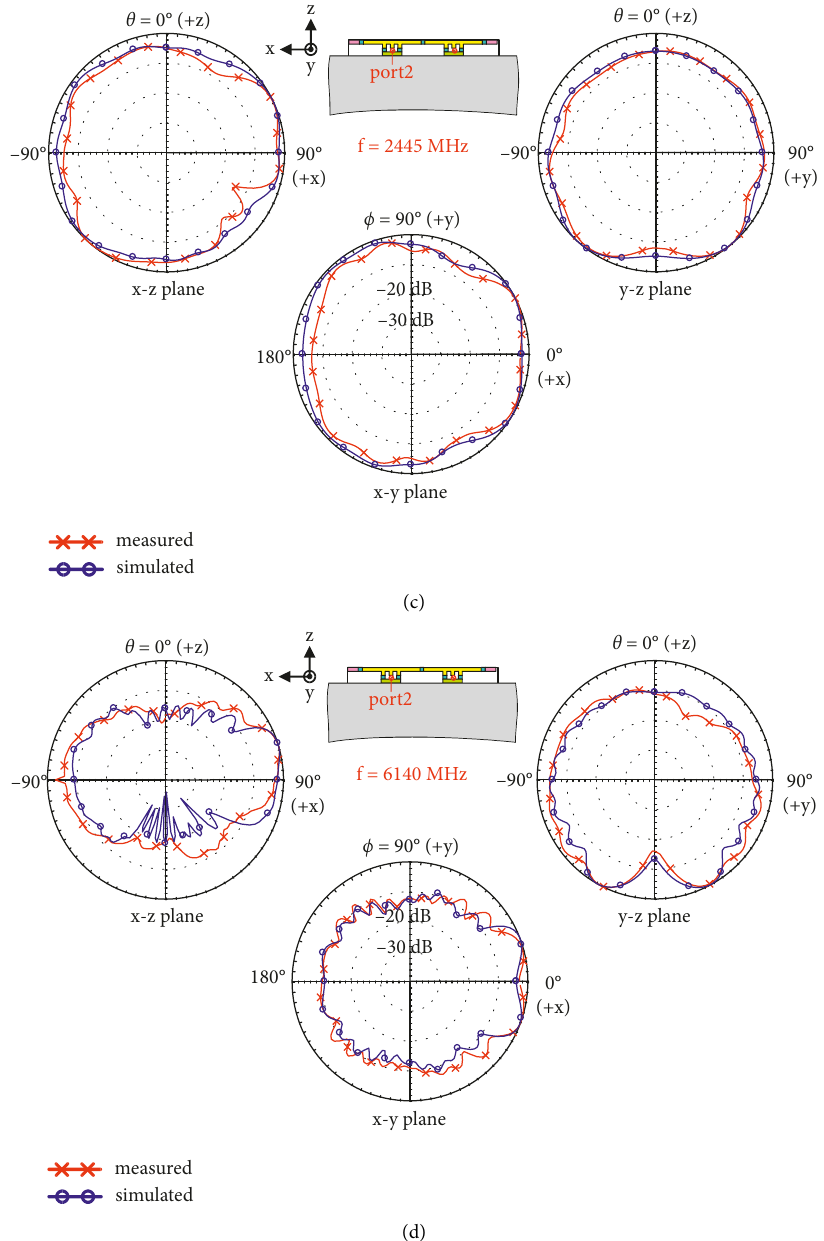
Figure 4: Measured 2-D radiation patterns ( E -total) at 2445 and 6140MHz. (a) Ant1. (b)